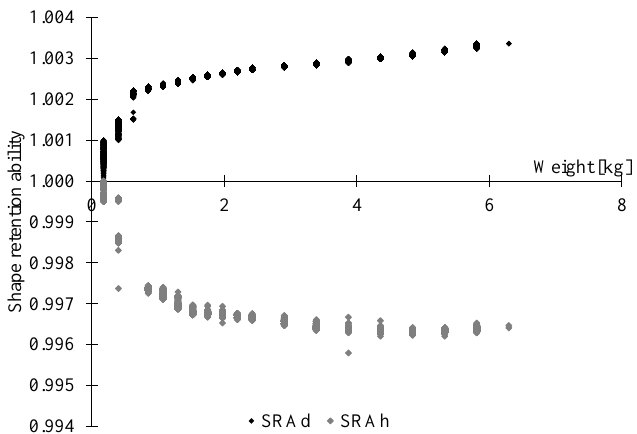
Figure 7. Shape retention ability indices.